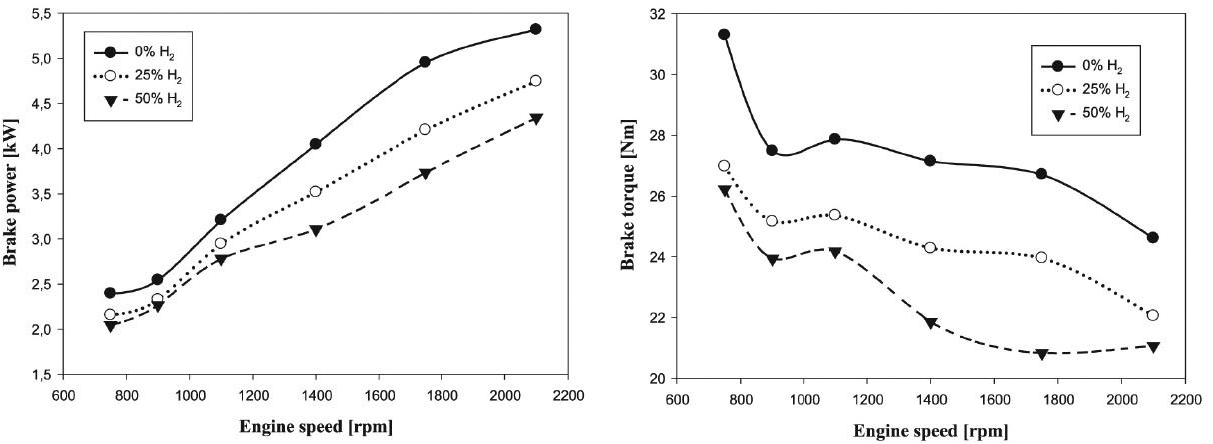
Figure 8. Brake power and brake torque changes with different percentages of hydrogen in the CI engine [73].